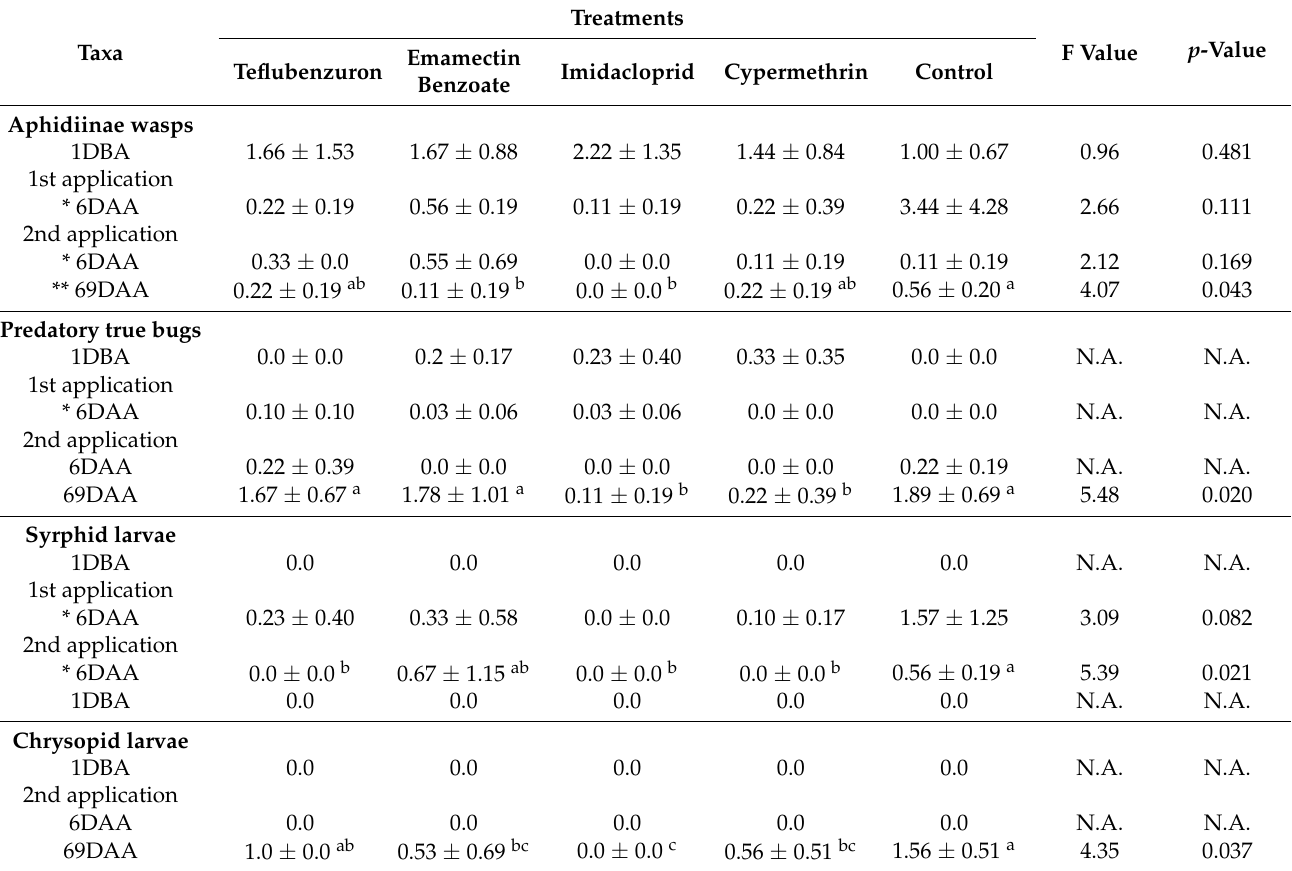
Table 4. Numbers of individuals of the most abundant insect natural enemies collected (mean no. per plant ± standard deviation) under different